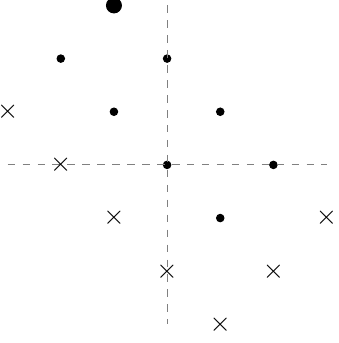
Figure 4. Example type I module in celestial CFT. For a radiative state ( ) with ∆ = 1 − | J | − n where n ∈ Z > , the predicted primary descendants and their descendants are identically zero ( × ). The radiative primary ( ) and its descendants ( ) thus form an n (2 | J | + n ) dimensional vector space. The axes intersect at (∆ , J ) = (1 , 0)